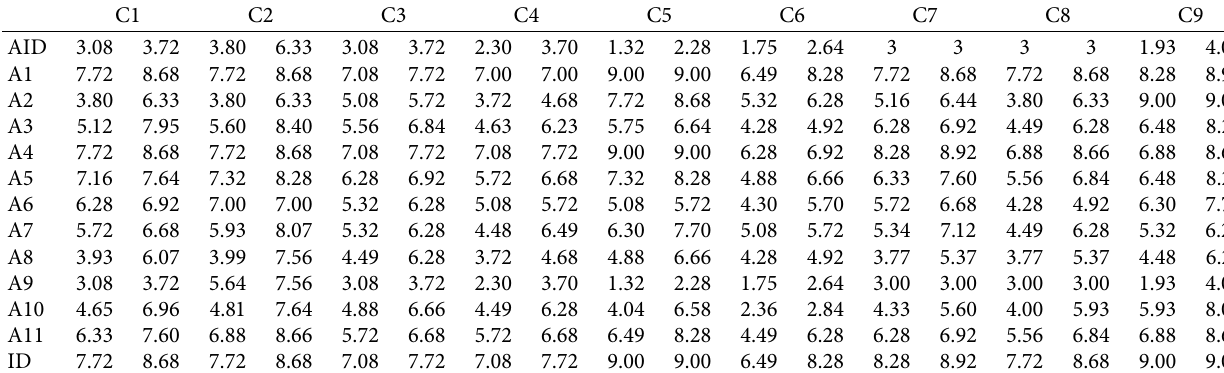
Table 10: Extended Rough Decision Matrix.